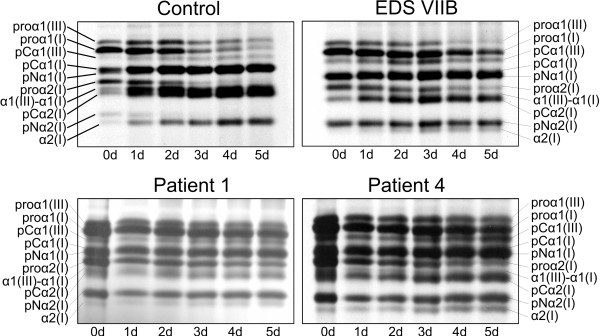
Pericellular processing of procollagen. The conversion of a pulse of [3H]-procollagen to collagen was followed over 5 days (d0-d5). The pulse chase analyses are shown for a control sample, P1, P4, and a patient with EDS arthrochalasis type due to an exon 6 skip in COL1A2 (EDS VIIB). In the control sample a clear decrease of the bands representing the pNα2(I) chain and increase of bands representing the mature α2(I) chains is observed over 5 days. Processing of the N-propeptide of type I collagen is delayed in both P1, P4 and in the patient with EDS VIIB. This is best seen by the accumulation of the bands representing pNα2(I) chains and a slower increase of mature α2(I) chains by day 5, compared to control.